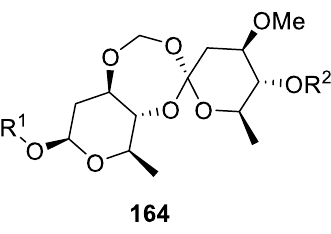
Figure 77. General structure of [5.6.0] spirocyclic orthoester periplosides.